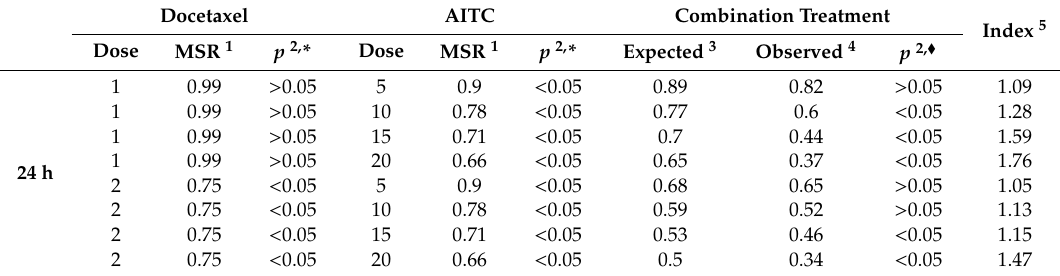
Table A1. Analysis of synergy between AITC and DOCE calculated by survival rate for PC-3